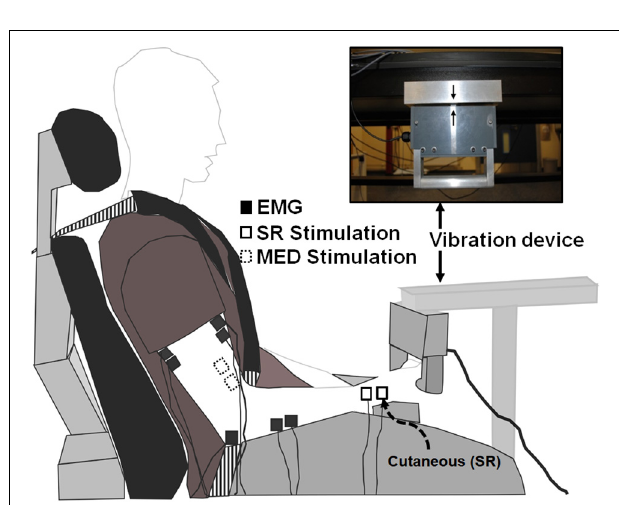
FIGURE 2 | Experimental setup. White boxes with dashed lines indicate the stimulation electrode placement on the median nerve proximal to the elbow on the inside of the arm to elicit Hoffmann (H-) reflexes. White boxes with solid lines indicate the stimulation electrode placement on the superficial radial nerve at the wrist to both elicit cutaneous reflexes and condition H-reflexes during separate trials. Black boxes indicate recording electrode placement to determine H-reflexes, cutaneous reflexes, and MEPs with electromyography